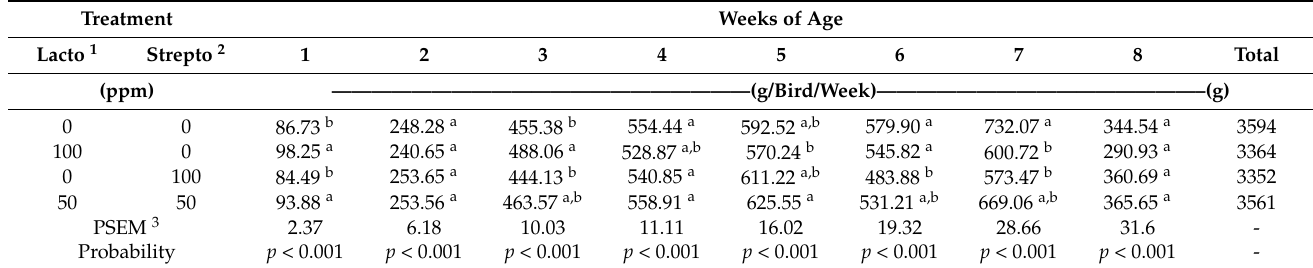
Probability p < 0.001